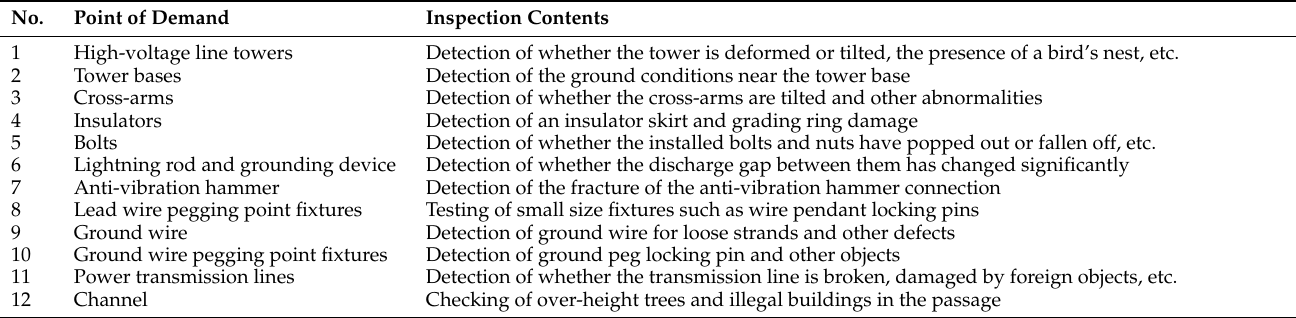
Table 1. High-voltage power transmission line inspection